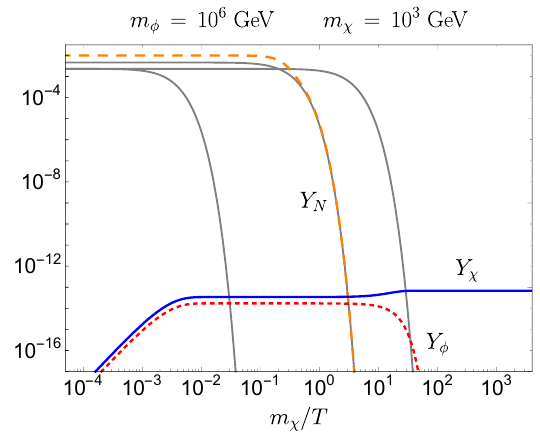
Figure 8 . The solution of the Boltzmann equations with m (cid:30) = 10 6 GeV, m (cid:31) = 10 3 GeV and the initial value of the RH neutrino yield Y N ( x R ) = 10 (cid:0) 2 . The RH neutrino mass is (cid:12)xed as M N = 10 4 GeV, but the DM abundance Y (cid:31) ( 1 ) does not depend on it.